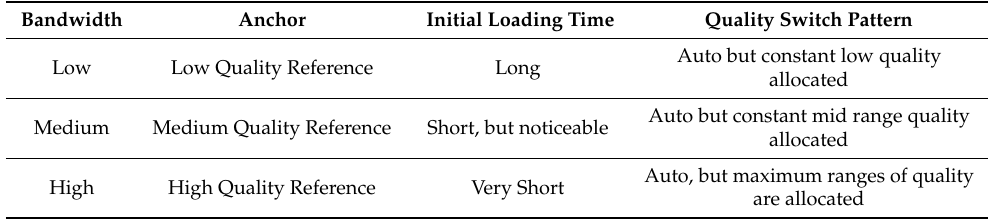
Table 4. Test Conditions (based on ITU-T